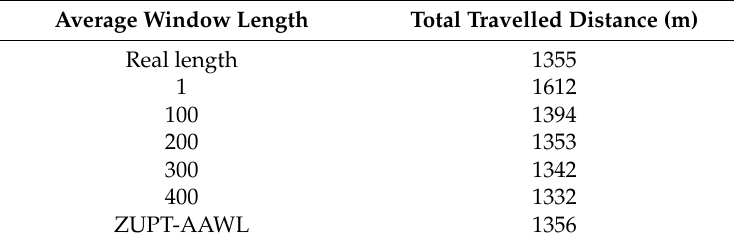
Figure 24. Relationship of total travelled distance and average window length. The red dots are range of ZUPT-AAWL average window length which ranges from 20 to 381 sampling points. Table 3. Typical total travelled distance results.